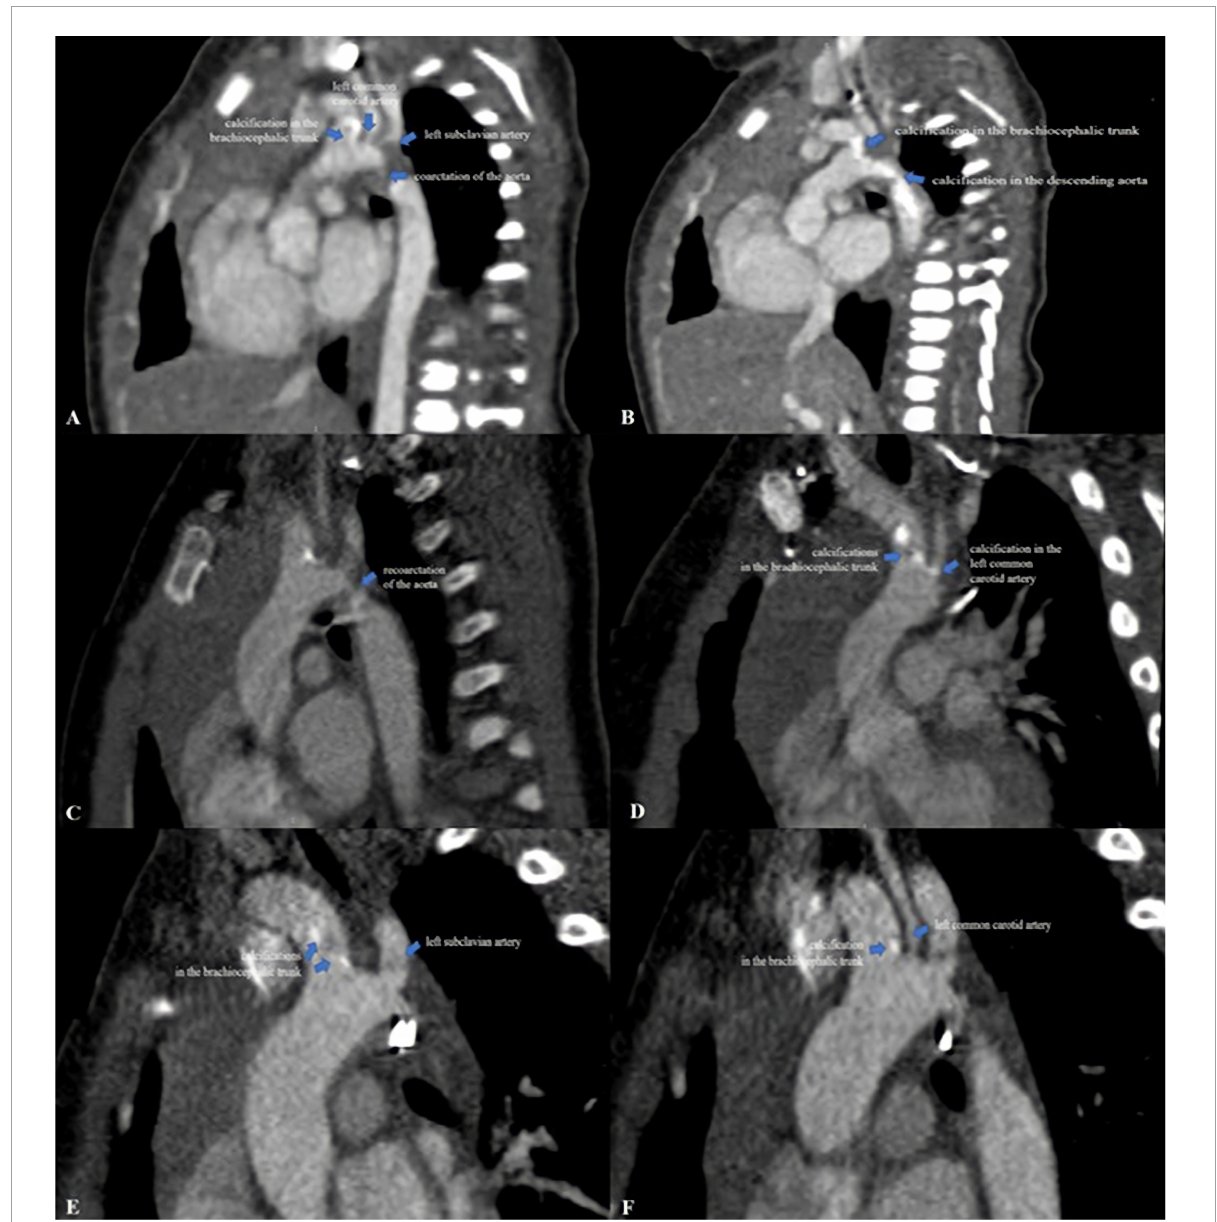
FIGURE3 (A,B) Computed tomography images from the neonatal period showing extensive ectopic calcifications in the aortic arch, brachiocephalic trunk, left common carotid artery, left subclavian artery and descending aorta with severe narrowing of the aorta mimicking coarctation of the aorta. Note the brightness of the walls of the aortic arch and descending aorta; (C,D) computed tomography images at 3-months of age showing re-coarctation of the aorta and residual calcifications in the brachiocephalic trunk and left common carotid artery without obstruction; (E,F) computed tomography images at 18-months of age showing the regression of the aortic arch calcifications without